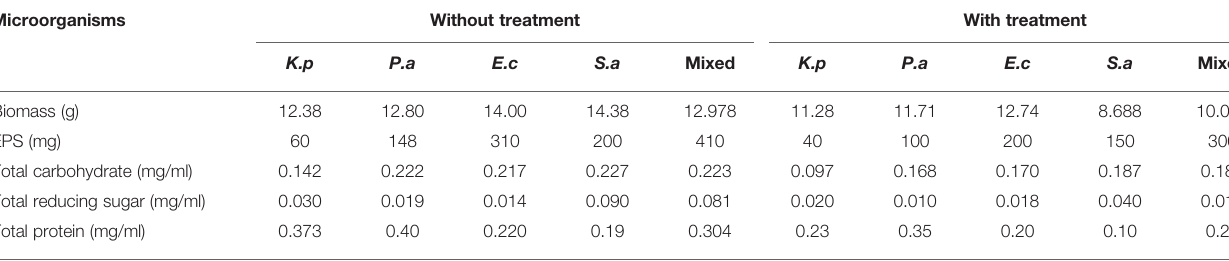
TABLE 4 | Effect of selected plant extract on the EPS inhibition and analysis of its content. Microorganisms Without